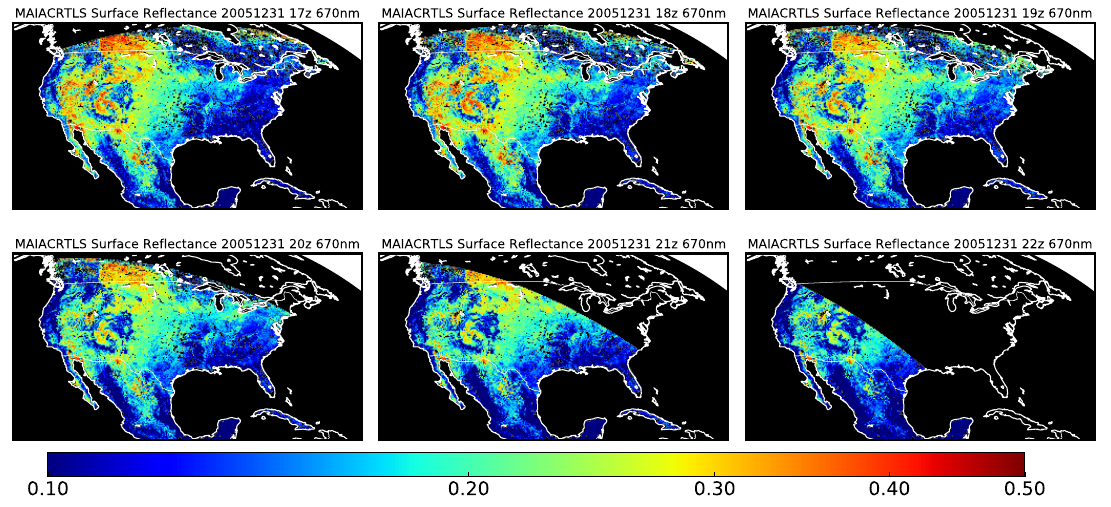
Figure 7. Simulated surface reflectance according to the MAIAC BRDF retrieval at 670 nm for the TEMPO sun-sensor geometry at 17–22 Z on 31 December 2005. Changes in the surface reflectance throughout the day are due to the bidirectional nature of the surface